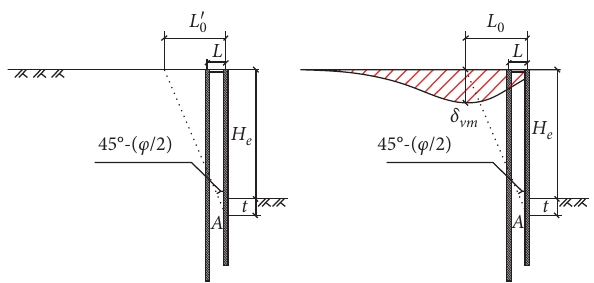
Figure 10: Schematic of the modified slip surface.